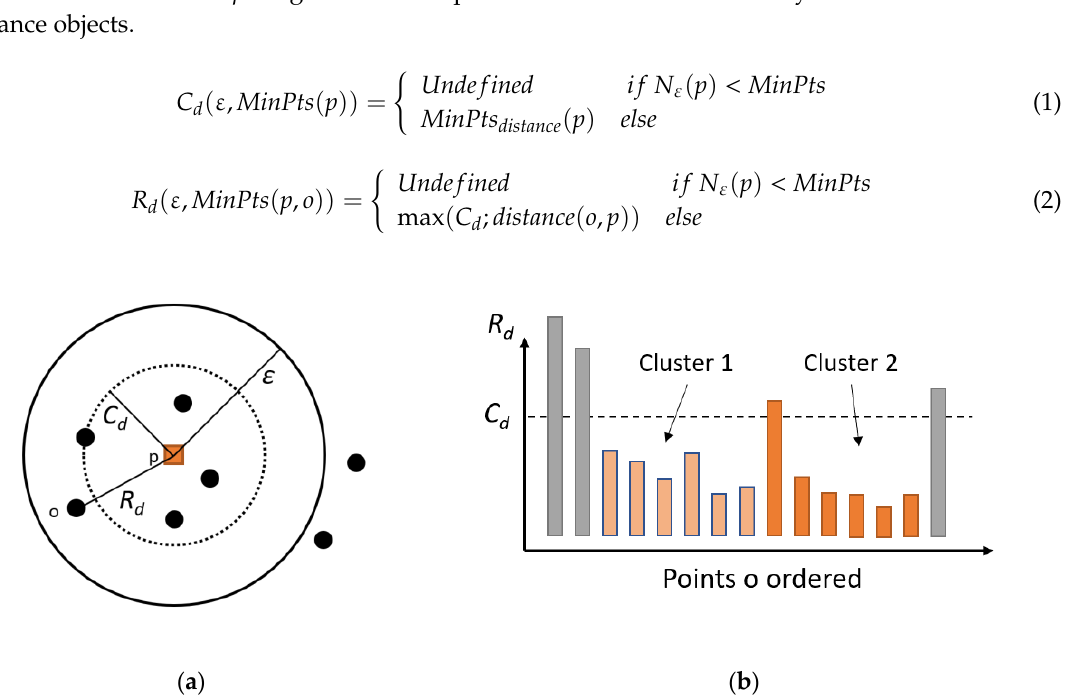
Figure 1. ( a ) Representation of the core distance and reachability distance for MinPts = 4. ( b ) Reachability plot.